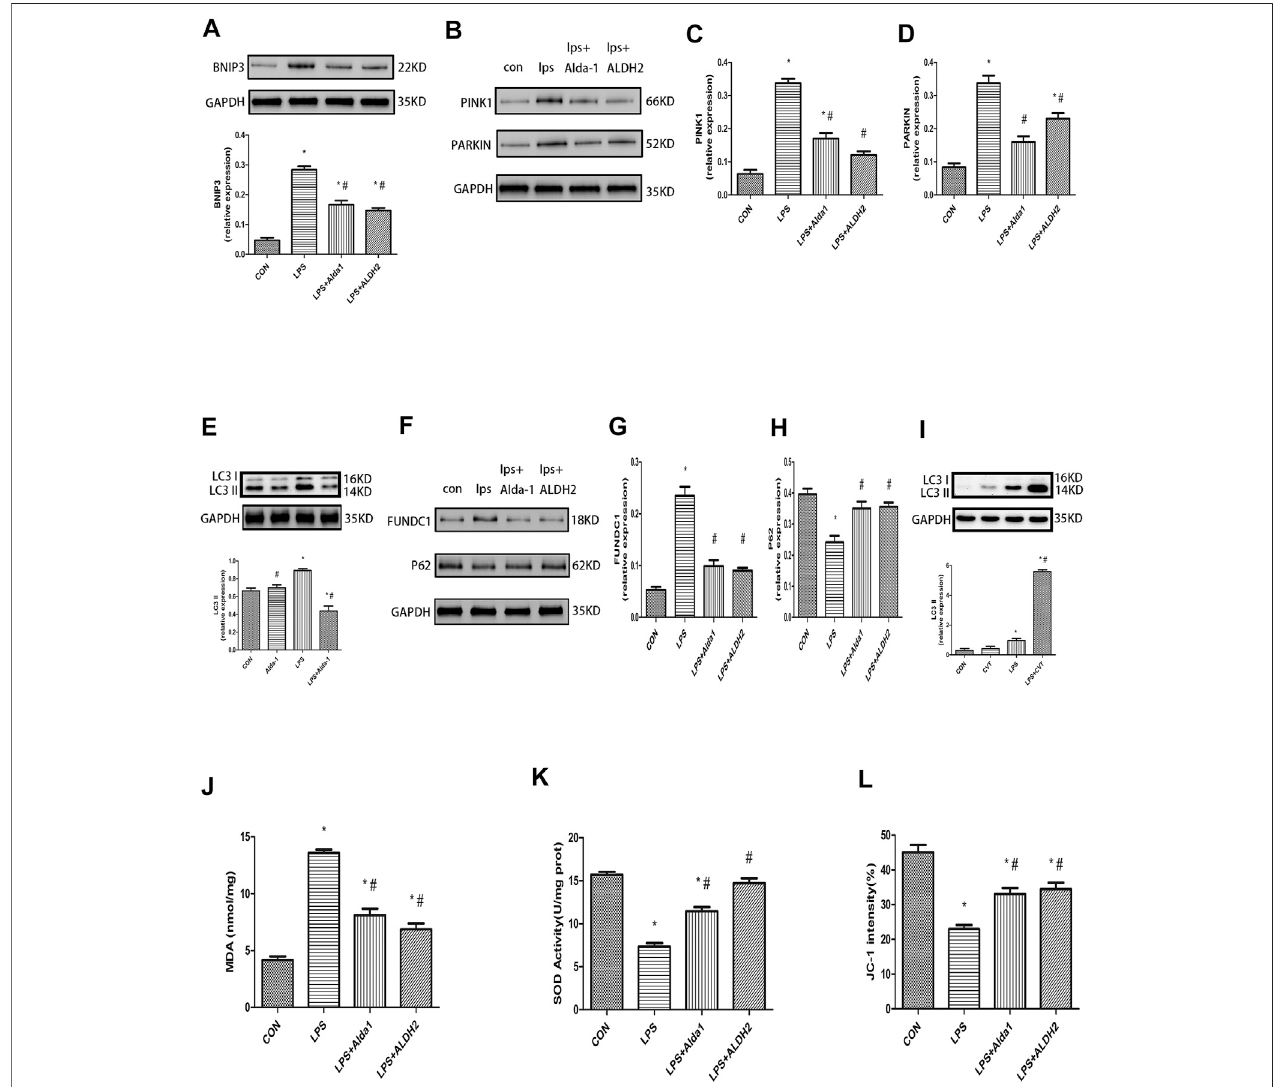
FIGURE 6 | Mitophagy, malondialdehyde (MDA), superoxide dismutase (SOD) activity, and mitochondrial membrane potential (MMP) in lipopolysaccharide (LPS)- treated mice. (A) Representative western blots and quanti fi cation analysis of BCL2-interacting protein 3 (BNIP3) and glyceraldehyde 3-phosphate dehydrogenase (GAPDH; loading control). (B) Representative western blots of phosphatase and tensin homolog-induced putative kinase 1 (PINK1), Parkin, and GAPDH (loading control). Quanti fi cation of (C) PINK1 and (D) Parkin. (E) Representative western blots and quanti fi cation of microtubule-associated protein 1 light chain 3 beta (LC3B) and GAPDH (loading control). (F) Representative western blots of FUN14 domain-containing 1 (FUNDC1), P62, and GAPDH (loading control). Quanti fi cation of (G) FUNDC1and (H) P62. (I) Representativewesternblotsandquanti fi cationofLC3BandGAPDH(loadingcontrol). (J) MDAlevelsinplasma. (K) SODactivityinplasma. (L) Quanti fi cationofJC-1intensityforMMP.Dataarethemean ± standarderrorofthemean. n (cid:1) 3mice/group.Statisticalanalyseswereperformedbyone-wayanalysis of variance, followed by Tukey ’ s post hoc test for multiple comparisons. * p < 0.05 vs. control (CON); # p < 0.05 vs. LPS.